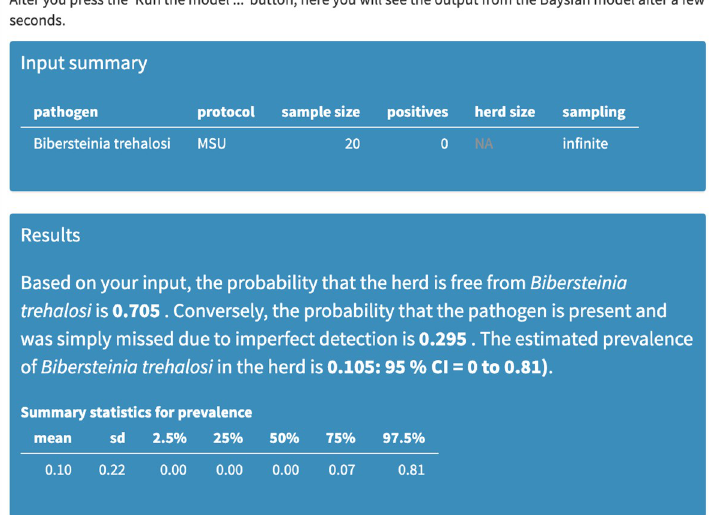
Fig 4. Summary output. These are the estimates of the probability the herd is free from a pathogen and prevalence assuming sampling from an infinite population. In this hypothetical example, 0 out of 20 animals tested positive for Bibersteinia trehalosi using the MSU testing protocol. Imperfect detection of the pathogen resulted in a substantial probability that the pathogen was present and simply missed (approximately